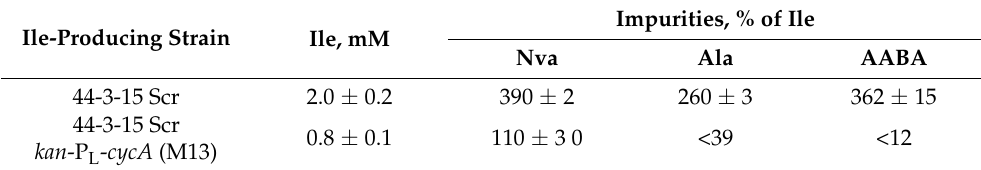
Figure 11. Schematic of BCAAs biosynthesis. Table 2. Influence of cycA overexpression on the accumulation of impurities by Ile-producing strain 44-3-15